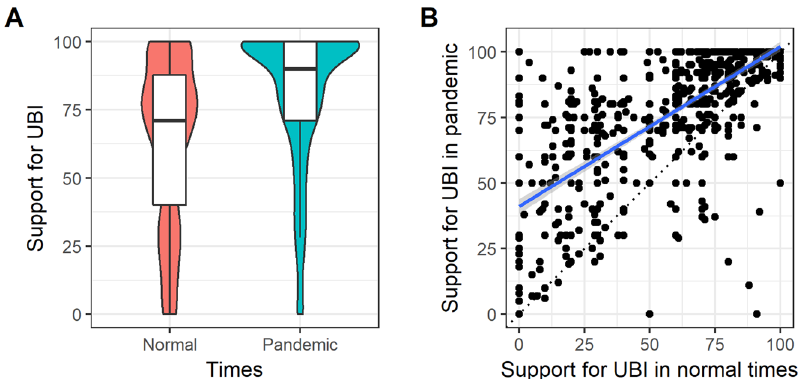
Fig. 1 Support for UBI in study 1. A Boxplots of UBI support in normal and in pandemic times. Violins show the distribution of the data. B Individual responses for UBI support in normal and pandemic times. The dotted line shows the line of equality, whilst the solid line is a linear fi t through the data.